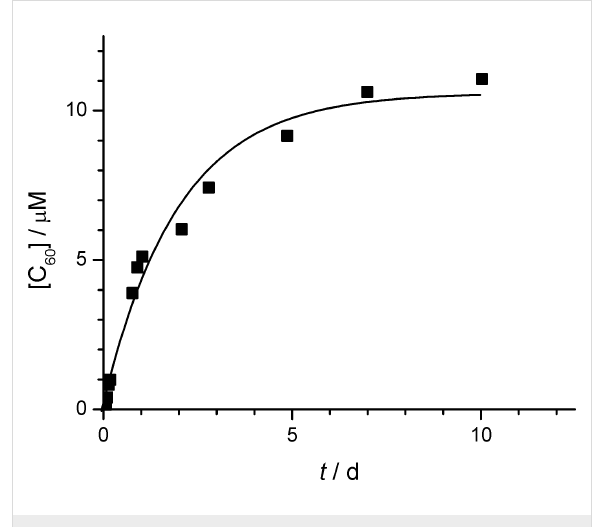
Figure 3: Isothermal kinetics of the dissolution of C 60 in the presence of 10 mM CD 7 in water. Curve: best fit of first-order kinetics k = 0.5 d − 1 = 0.021 h − 1